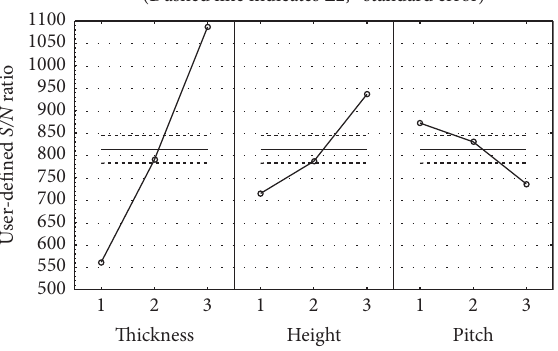
Figure 23: Mean plot of